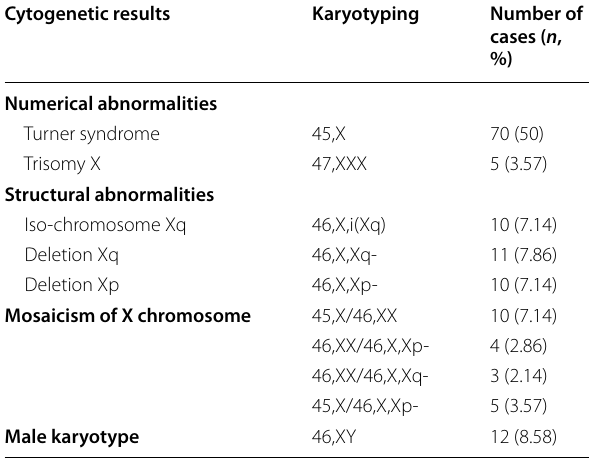
Data are expressed as numbers and